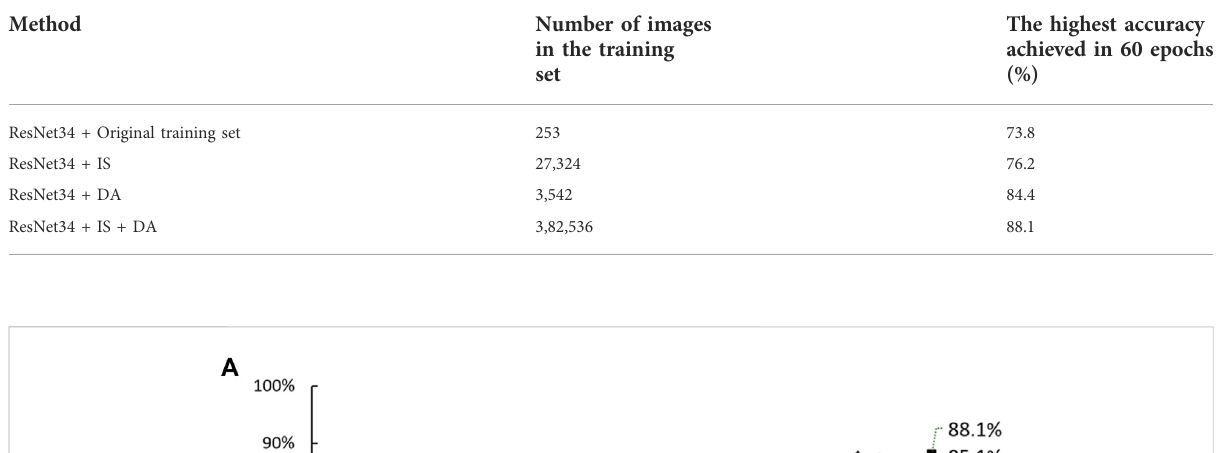
TABLE 3 Comparison of training results for different data preprocessing methods.